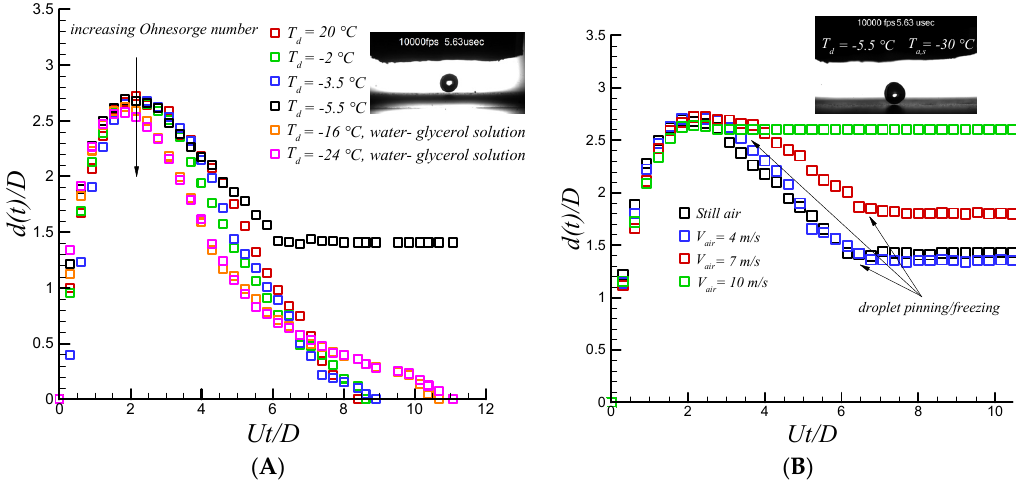
Figure 6. Temporal evolution of impacting water droplet on superhydrophobic substrate at different temperature ( A ); Effect of air flow on impacting supercooled water drop on superhydrophobic substrate below critical temperature of heterogeneous nucleation ( B ). Droplet size and impact velocity are 2.6 mm and 1.6 m/s, respectively.